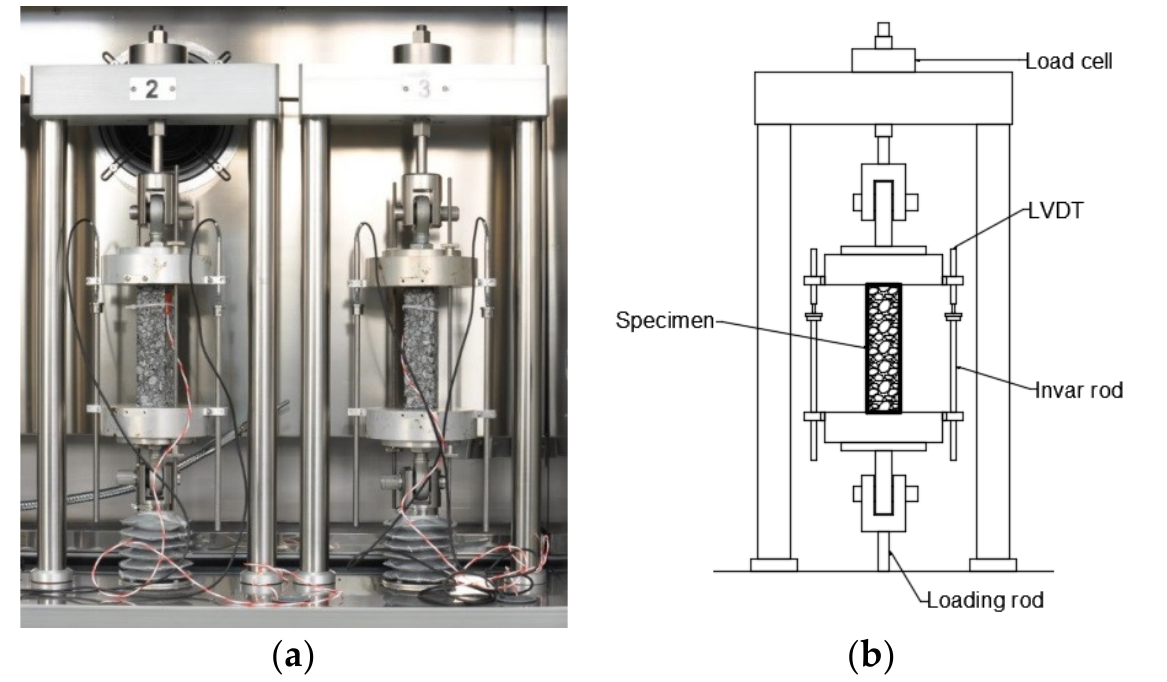
Figure 5. Thermal stress restrained specimen test (TSRST) setup. ( a ) Photograph of specimens during the test; ( b ) Schematic view [15].